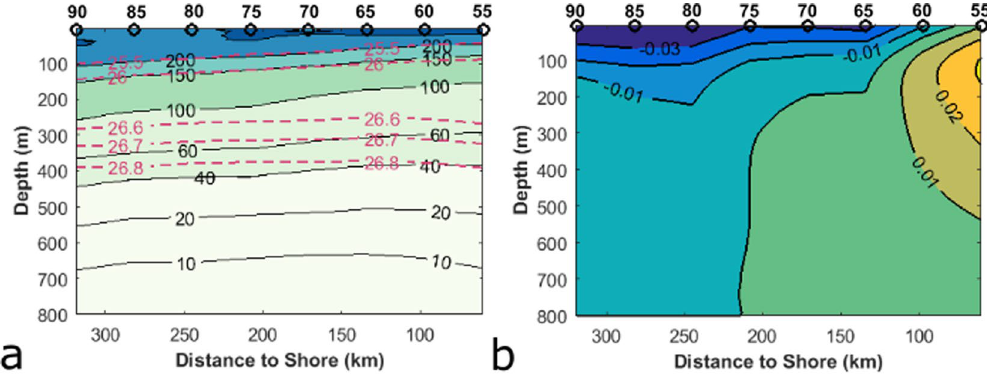
Figure 2. ( a ) Mean dissolved oxygen along Line 67 ( µ mol kg − 1 ) and contours of potential densities 25.5, 26.0, 26.6, 26.7, and 26.8 kg m − 3 (red, dashed). ( b ) Mean annual alongshore velocity at Line 67 (m/s). Positive values denote poleward alongshore flow. Black circles mark hydrographic stations.